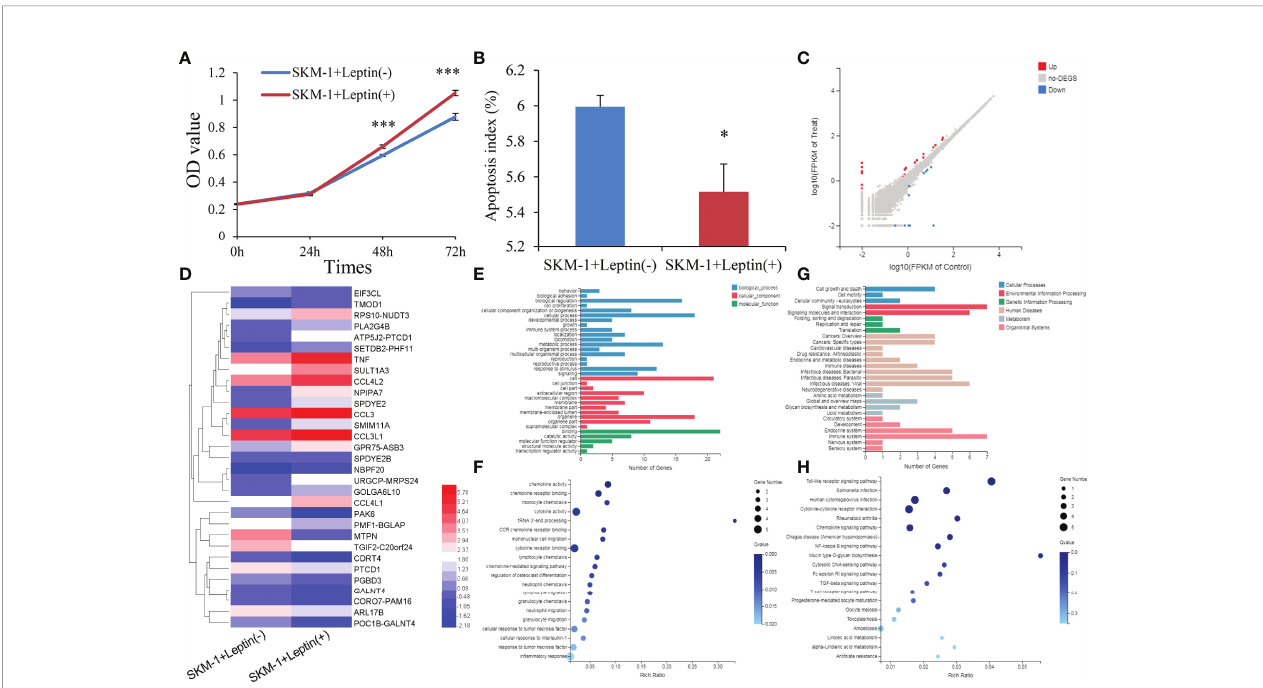
FIGURE 5 | Biological functions of LEP in MDS cell line SKM-1. (A) The proliferation ability in SKM-1 cells before and after human recombinant leptin treatment. (B) The apoptosis ability in SKM-1 cells before and after human recombinant leptin treatment. (C) Volcano plot of differentially expressed genes between SKM-1 cells before and after human recombinant leptin treatment. (D) Expression heatmap of differentially expressed genes between SKM-1 cells before and after human recombinant leptin treatment. (E, F) Gene Ontology analysis of differentially expressed genes. (G, H) Gene Ontology and Kyoto Encyclopedia of Genes and Genomes analysis of differentially expressed genes. P -values were calculated using the independent T-test. * P < 0.05; *** P <